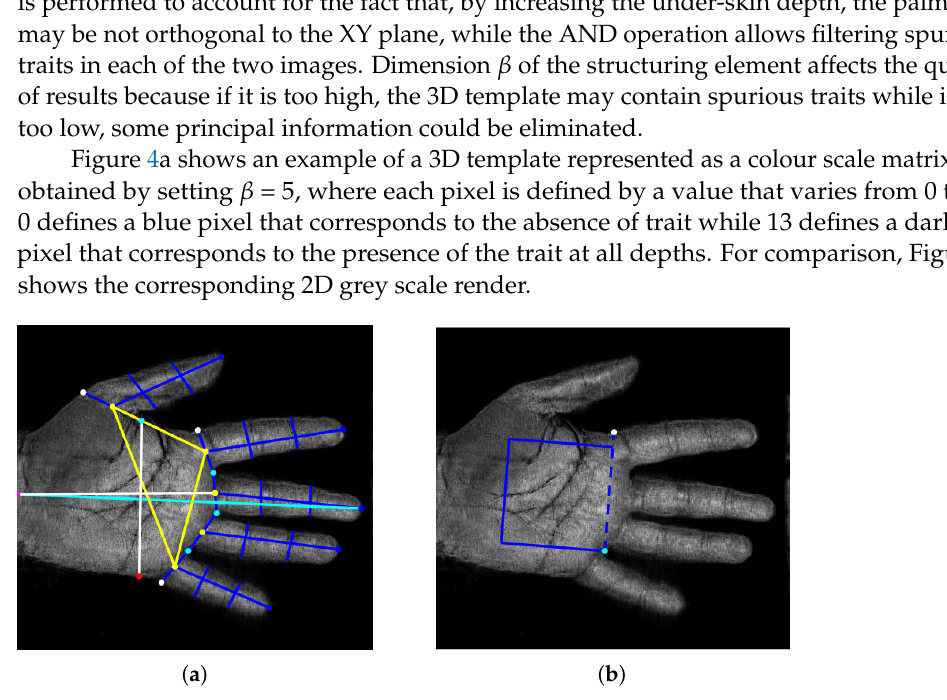
Figure 2. ( a ) Feature points extracted from the hand shape and the 26 distances defining the 2D template; ( b ) ROI extraction for palmprint from two feature points of ( a ).